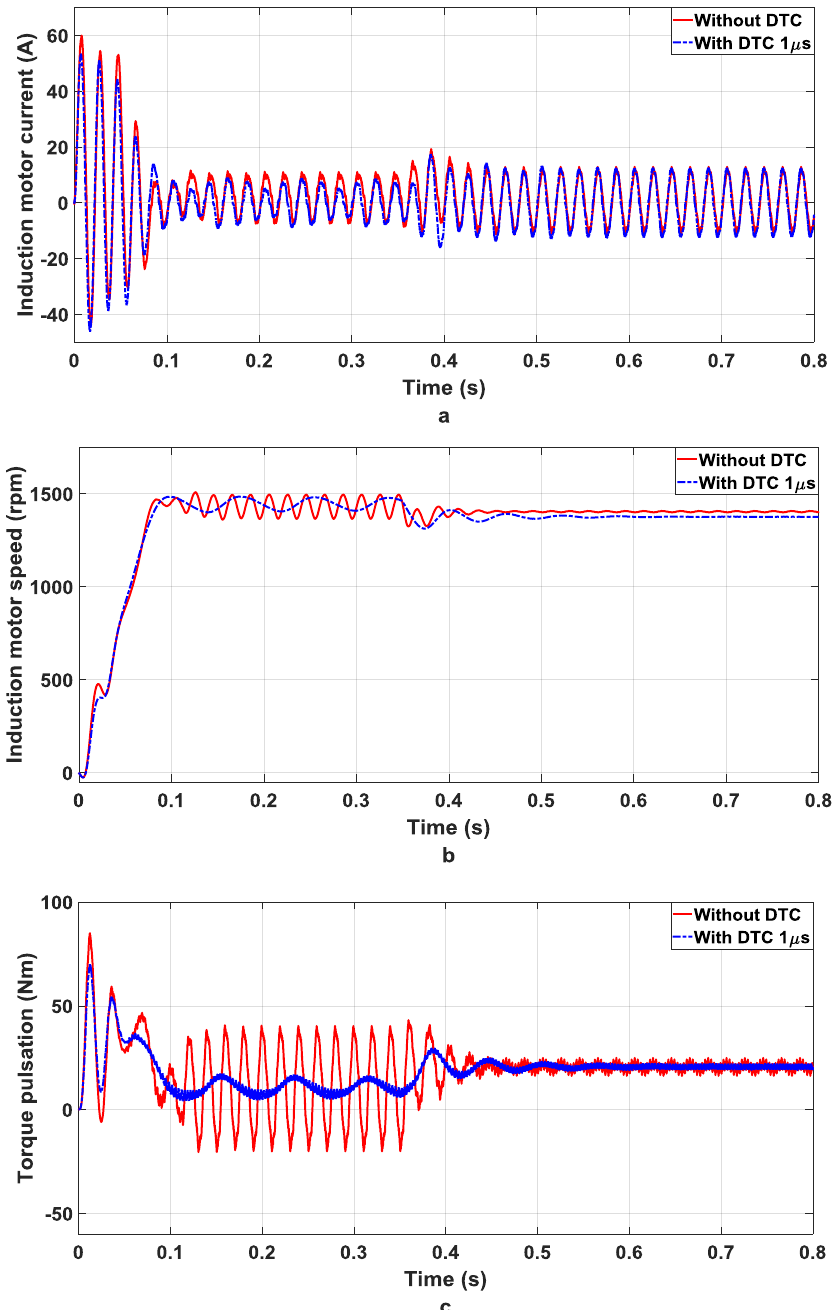
Figure 15. Without/with 1 𝜇 s DTC ( a ) induction motor current ( b ) speed of induction motor ( c ) Figure 15. Without / with 1 µ s DTC ( a ) induction motor current ( b ) speed of induction motor Torque pulsation. ( c ) Torque